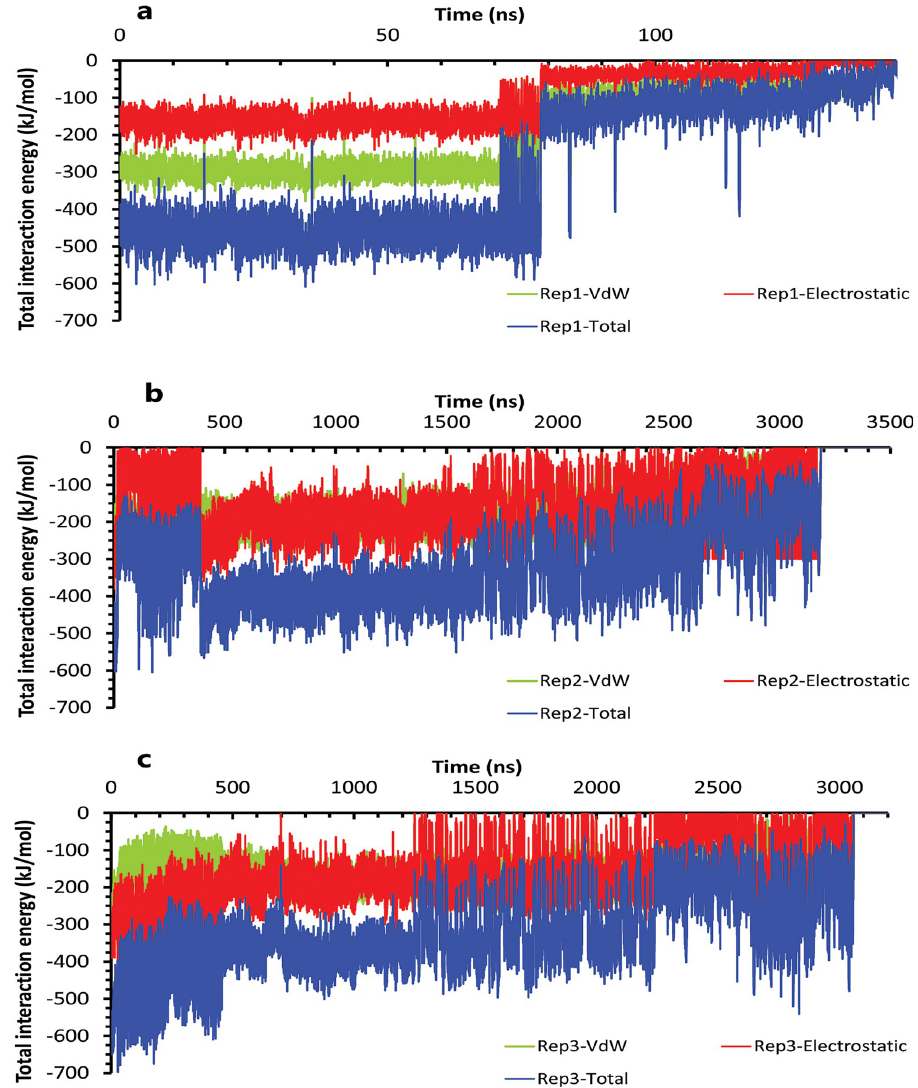
Fig 12. The interaction energies plots of compound 9 in complex with HTLV-1 protease when Asp32 of chain A was protonated in three replicas. A , B , and C , The total VdW and electrostatic interactions energies of protein- inhibitor complexes in rep1, 2, and